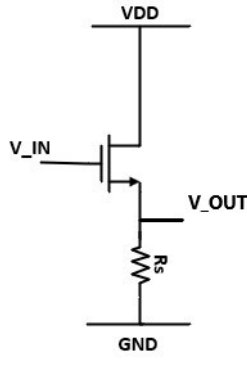
Figure 8. Test-point